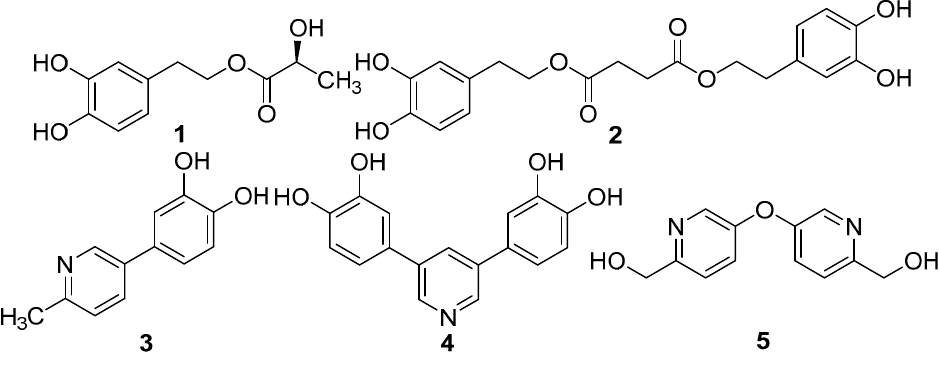
Figure 1. Structures of compounds 1 – 5 .